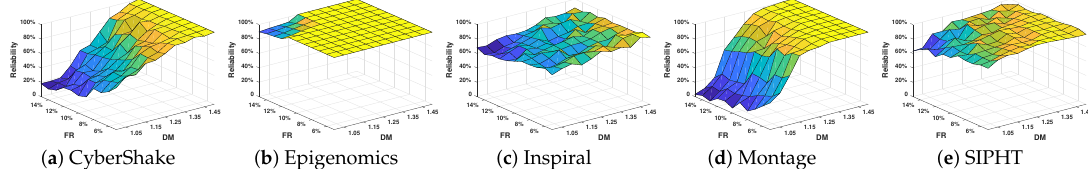
Figure 6. Reliability of real-world workflows with increasing DM and decreasing FR.